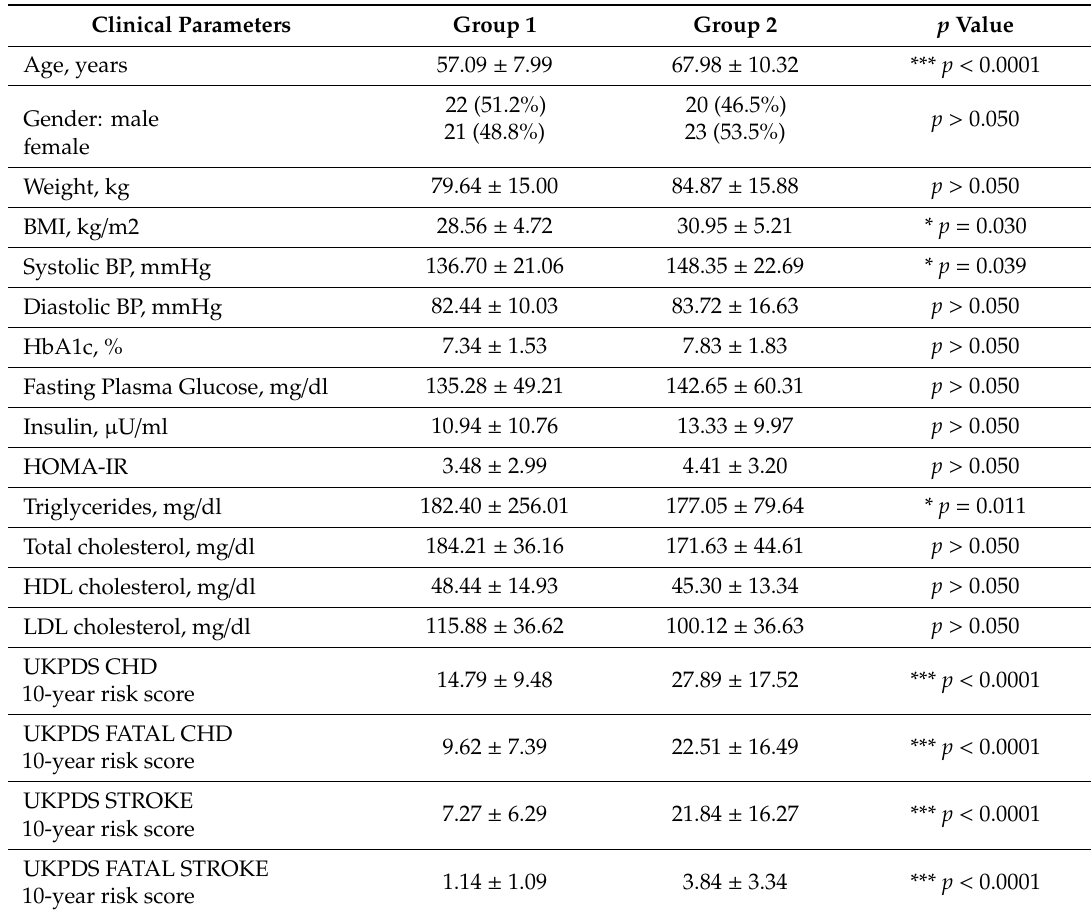
Table 2. Demographic and clinical parameters of study